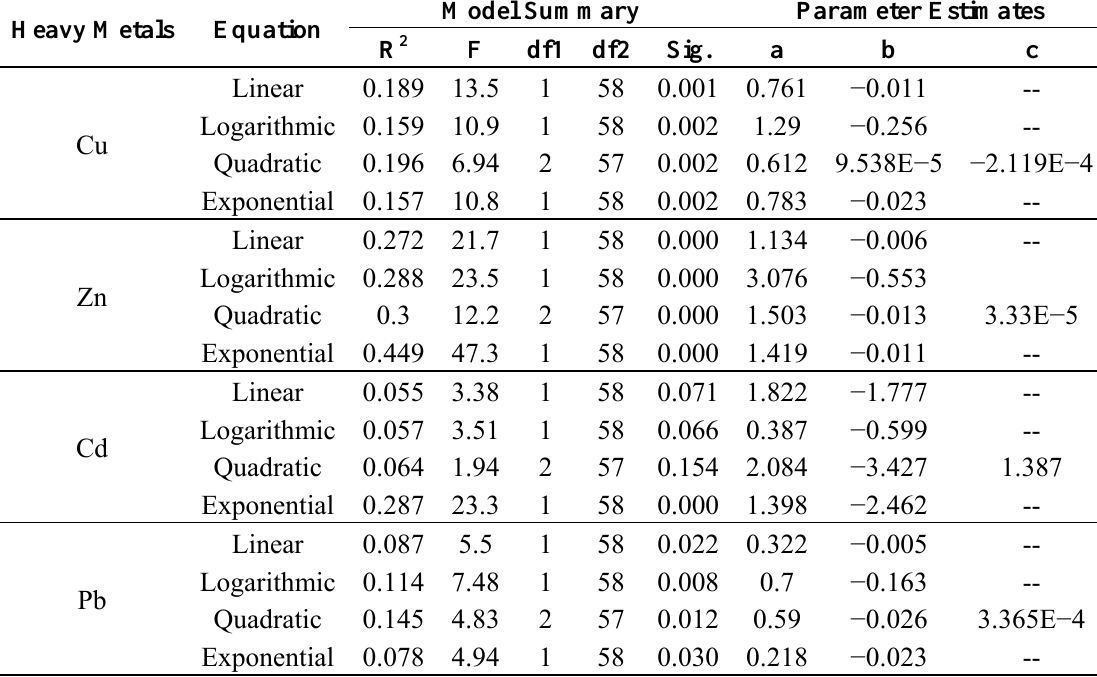
Table 8. Models’ parameters and goodness-of-fit